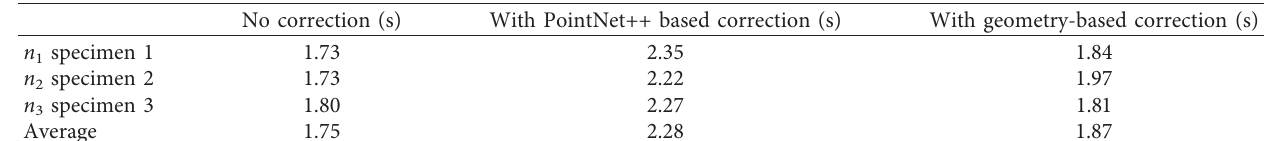
Table 2: Average 3D reconstruction calculation time.